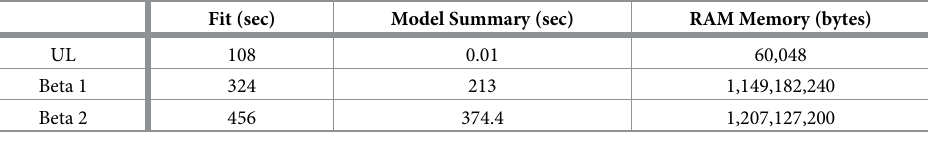
Table 7. Computational cost (time and memory space) required for each regression model (Phase I